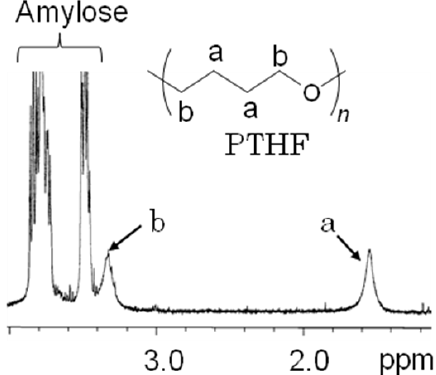
Figure 6. 1 H NMR spectrum of amylose-PTHF inclusion complex in NaOD/D